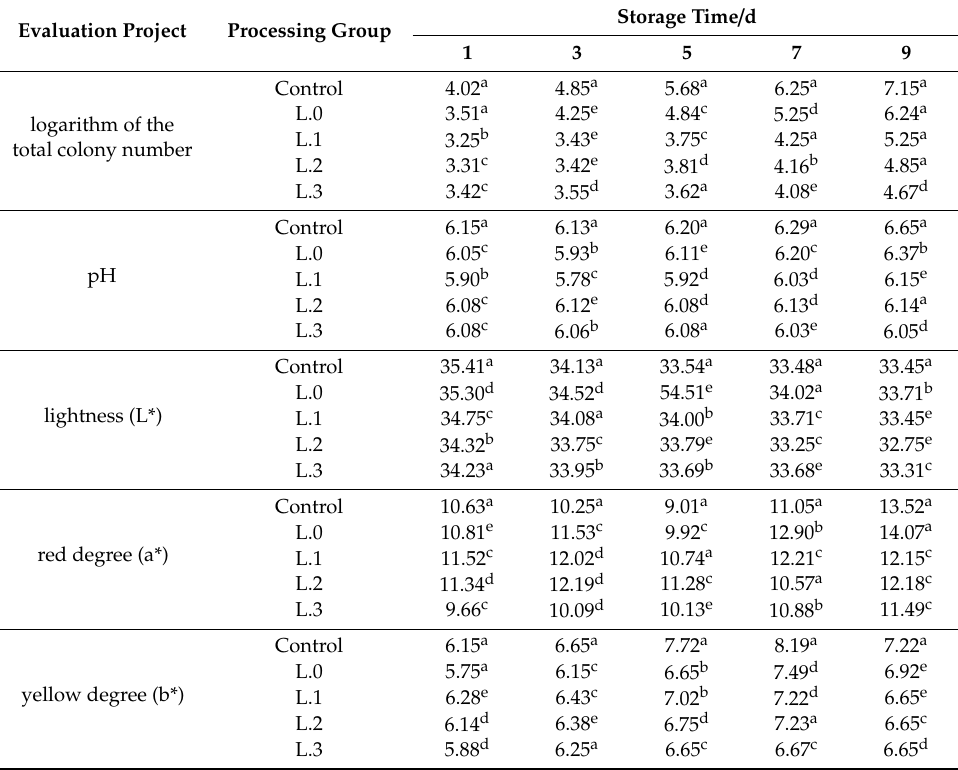
Table 3. Parameter fresh pork during storage at 4 ◦ C for 9